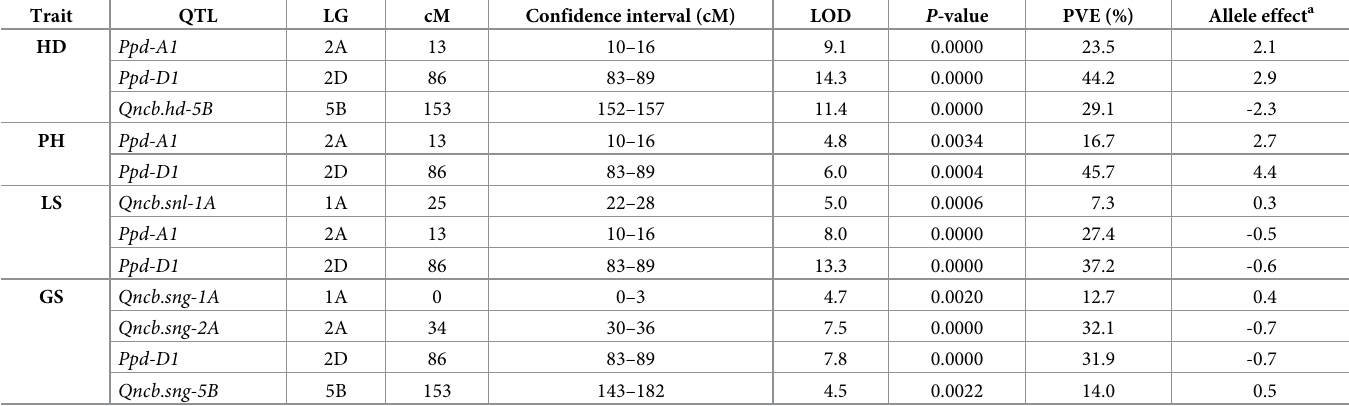
Table 2. Quantitative trait loci (QTL) in the GADH population associated with heading date, plant height, and SNB severity combined across years, using the com- posite interval mapping approach. Trait